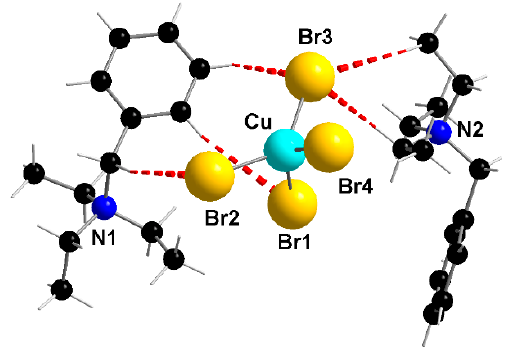
Figure 1. Molecular structure of (BzlEt 3 N) 2 [CuBr 4 ] ( 5 ), hydrogen contacts are presented as fragmented lines. Table 3. Hydrogen contacts for (BzlEt 3 N) 2 [CuBr 4 ] ( 5 ). Table 2. Selected bond lengths and bond angles of (BzlEt 3 N) 2 [CuBr 4 ] ( 5